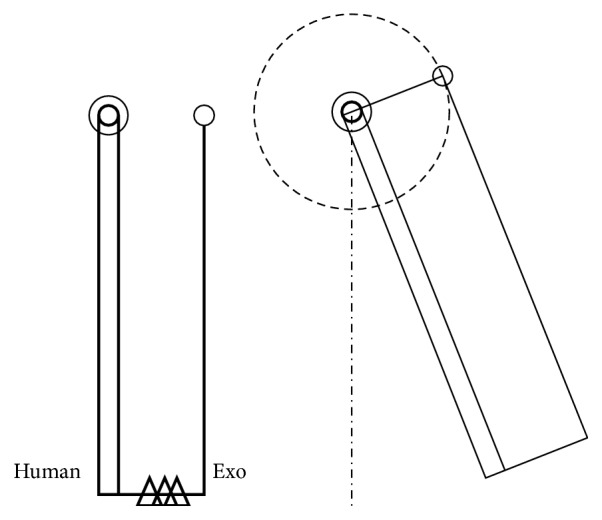
Schematic representation of human-exoskeleton interaction during abduction. Considering that the human hip joint is the driving force of the motion, abduction of the hip causes a rotation of both the thigh and the exoskeleton around the human abduction axis.